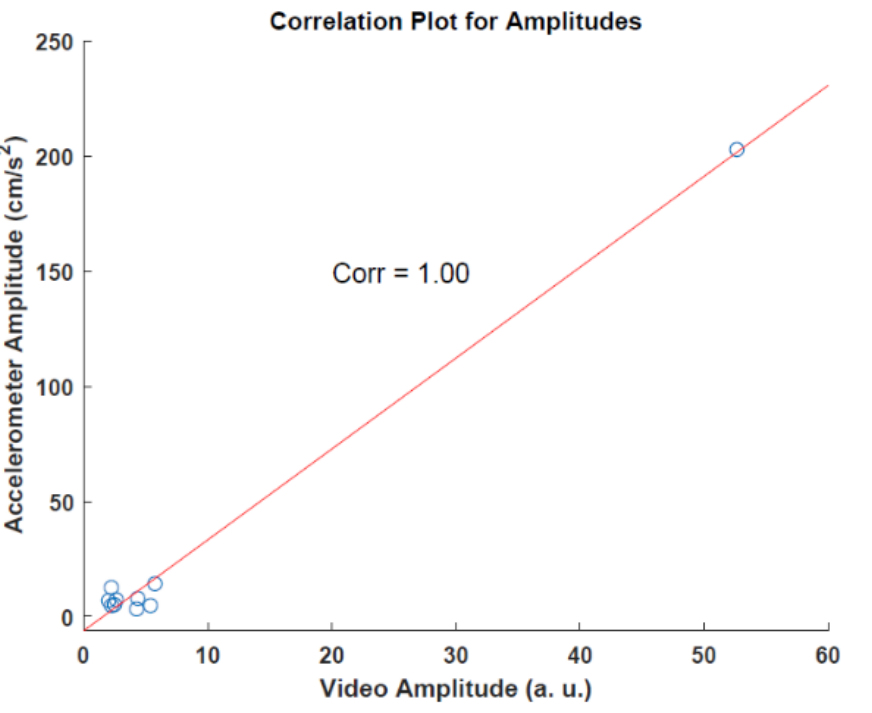
Figure 8. Correlation analysis for amplitudes.